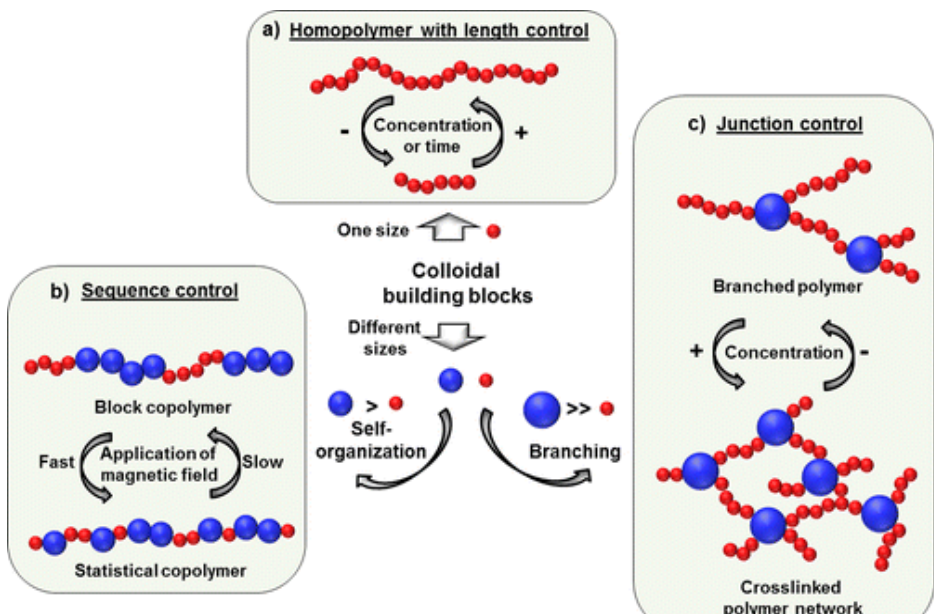
Figure 11. Controlled assembly and fusion of superparamagnetic polystyrene nanoparticles; schematic representation. ( a ) Insertion of a monodisperse nanoparticle dispersion yields predominantly linear nanochains. Depending on the concentration of the nanoparticle dispersion (and the growth time), longer or shorter chains can be obtained. ( b ) In the case of a polydisperse sample, the di ff erent sized particles (colored in red and blue representing small and large particles, respectively) can self-organize into blocks of larger and smaller particles, resulting in colloidal block copolymers or in rather statistical fashion. A slow increase of the external magnetic field assembles the particles in a rather block-like pattern, while a fast increase assembles the particles in a rather statistical fashion. ( c ) The insertion of particles with even larger size di ff erences enables the introduction of junction points. Here, more than twosmallnanoparticlesassemblearoundalargeparticlecreatingajunctionpointwithinthenanoparticle chain. By increasing the concentrations of nanoparticles in the dispersion, networks of cross-linked chains can be obtained. (Reprinted with permission from [179]. Copyright 2015 American Chemical